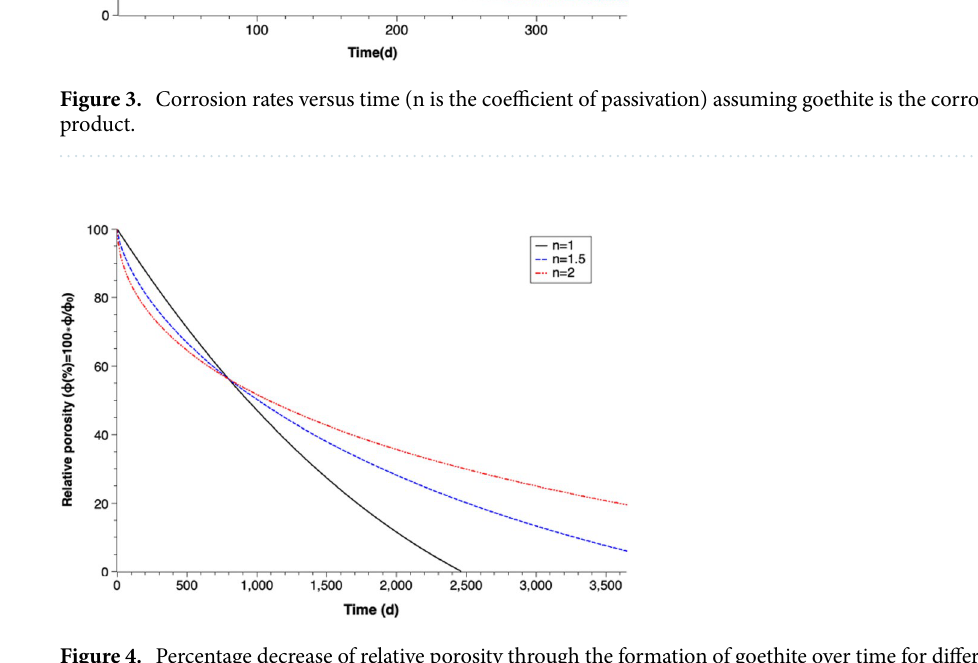
(cid:31) (cid:31) 0